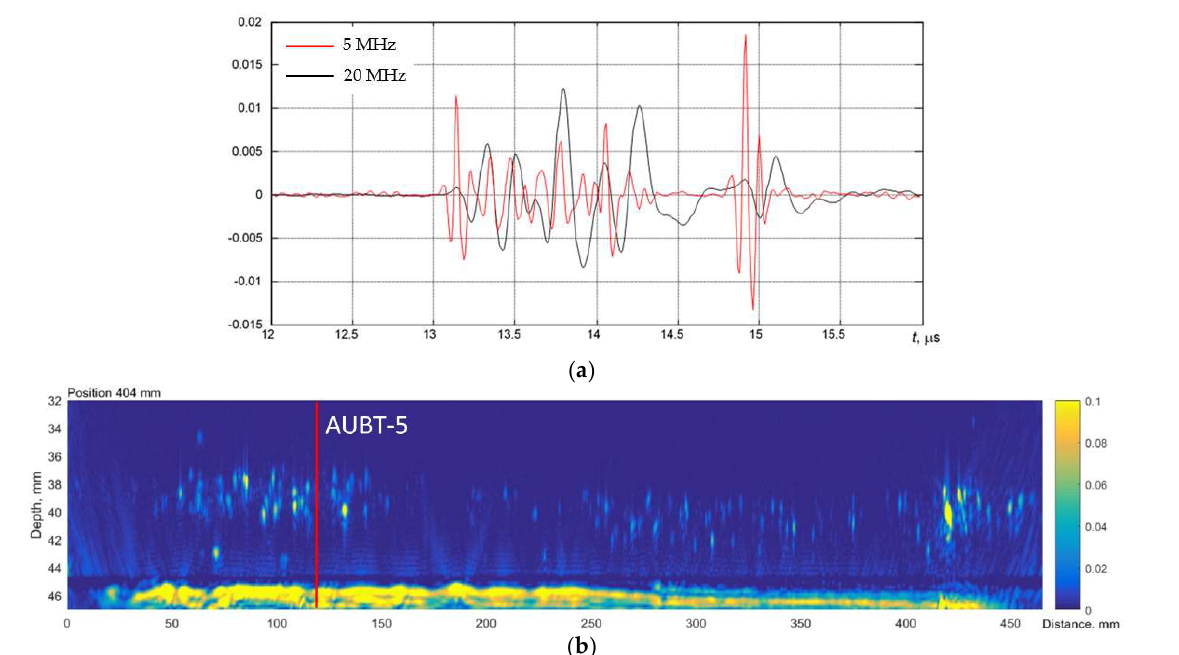
Figure 11. ( a ) The waveforms of the received signals at the point AUBT-4 with 5 MHz (black) and 20 MHz (red) transducers and ( b ) the corresponding TFM image, showing appropriate AUBT meas- urement location. Vertical colour bar represents the peak-to-peak amplitude in arbitrary units.